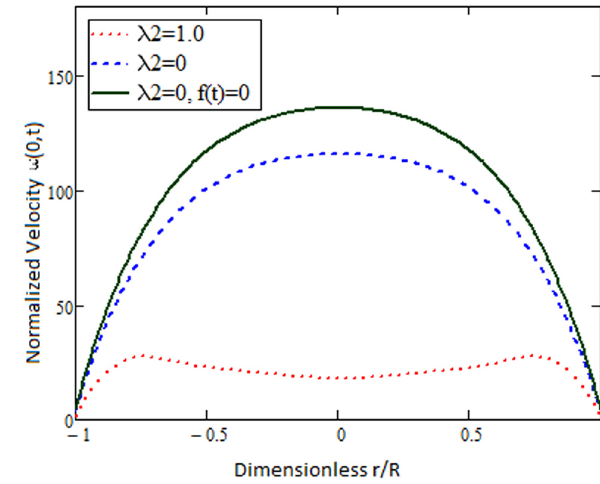
Figure 1: In the pipe behavior of fl ow when